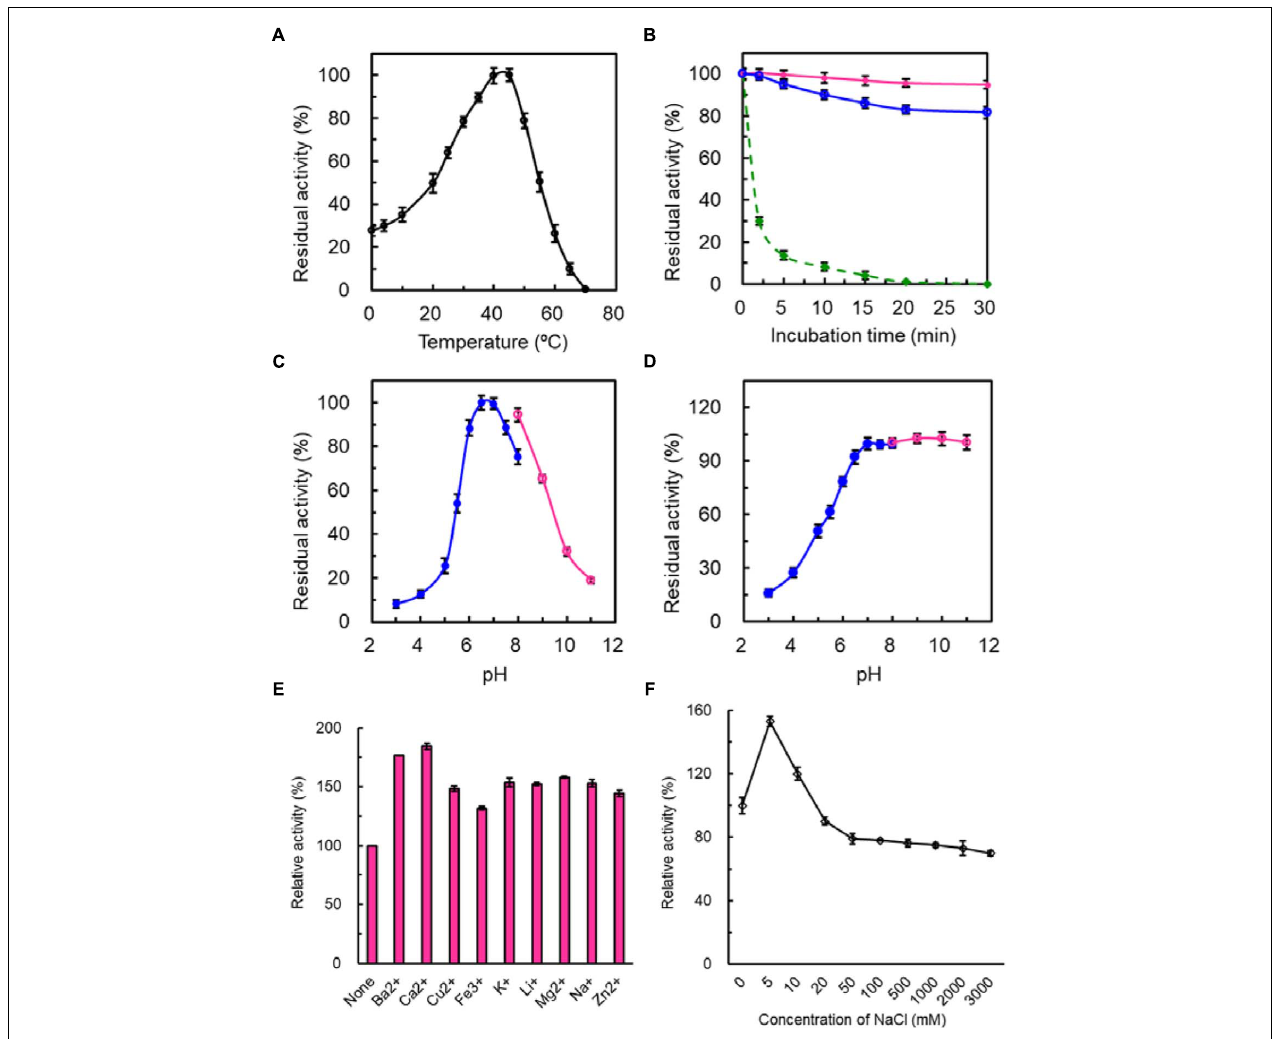
FIGURE 3 | Enzymatic properties of purified SdG5A. (A) Effect of temperature on the catalytic activity. The temperature profile was determined in C 4 H 2 O 7 –Na 2 HPO 4 buffer (pH 6.5) at different temperatures ranging from 0 to 70 ◦ C. The activity of the enzyme at 45 ◦ C was taken as 100%. (B) Effect of temperature on protein stability. To assess the thermostability, the enzyme was incubated at 25 ◦ C (pink), 35 ◦ C (blue), and 45 ◦ C (green). The residual activity was measured at pH 6.5 and 45 ◦ C. The activity before the incubation was taken as 100%. (C) Effect of pH on the catalytic activity. The pH profile was determined in 50 mM C 4 H 2 O 7 –Na 2 HPO 4 buffer at pH range of 2.5–8.0 (blue) and 50 mM glycine-NaOH buffer at a pH range of 8.0–11.0 (pink) at 45 ◦ C. The maximum activity obtained at pH 6.5 was considered as 100%. (D) Effect of pH on protein stability. The pH stability was determined by incubating the enzyme in 50 mM C 4 H 2 O 7 –Na 2 HPO 4 buffer at pH range of 2.5–8.0 (blue) and 50 mM glycine-NaOH buffer at pH range of 8.0–11.0 (pink) for 1 h at 4 ◦ C and the residual activity was measured at pH 6.5 and 45 ◦ C. The activity before the incubation was taken as 100%. (E) Effect of different metal ions on the catalytic activity. The activity of